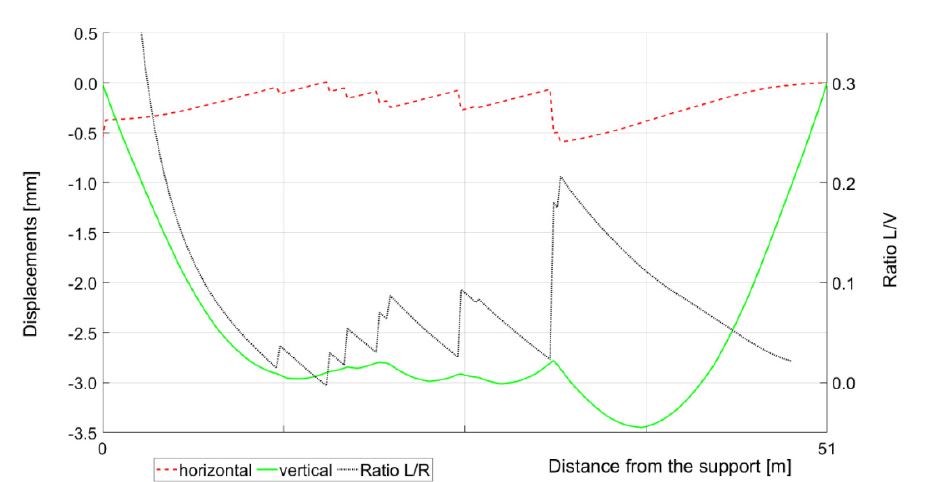
Figure 7. View of bridge No 2.